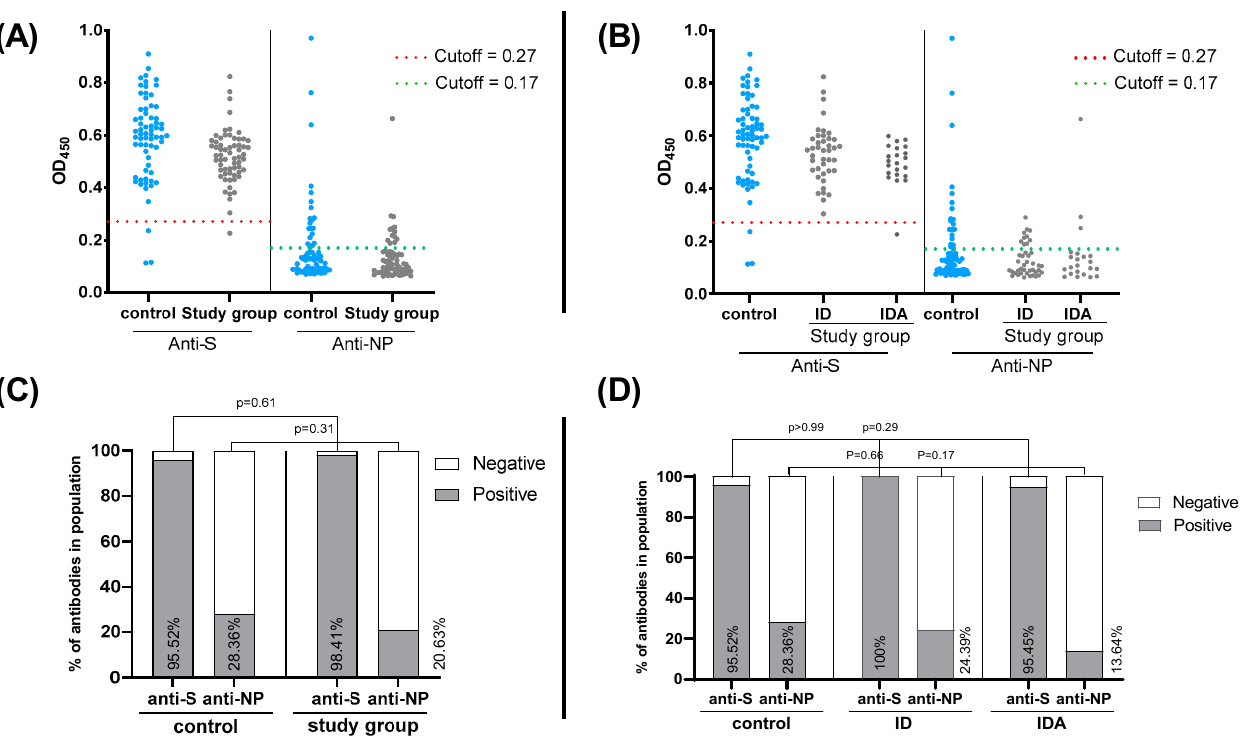
Figure 2. Optical density (OD) values and the prevalence of anti- SARS-CoV-2 S and NP IgGs among control group (normal hemoglobin and ferritin) and study group (ID, IDA). ( A , B ) Optical density values at 450 nm (OD450) as obtained from S- and NP-based ELISAs for control and study group: ( A ) ID and IDA combined and ( B ) ID and IDA separated. Dashed red lines represent the cut-off value for S-ELISA (OD450 = 0.27) and dashed green lines represent NP-ELISA cut-off value (OD450 = 0.17). ( C , D ) The prevalence (%) of anti-S and anti-NP in control and study group: ( C ) ID and IDA combined and ( D ) ID and IDA separated. p values were calculated by Fisher’s exact test, p value < 0.05 is considered significant.